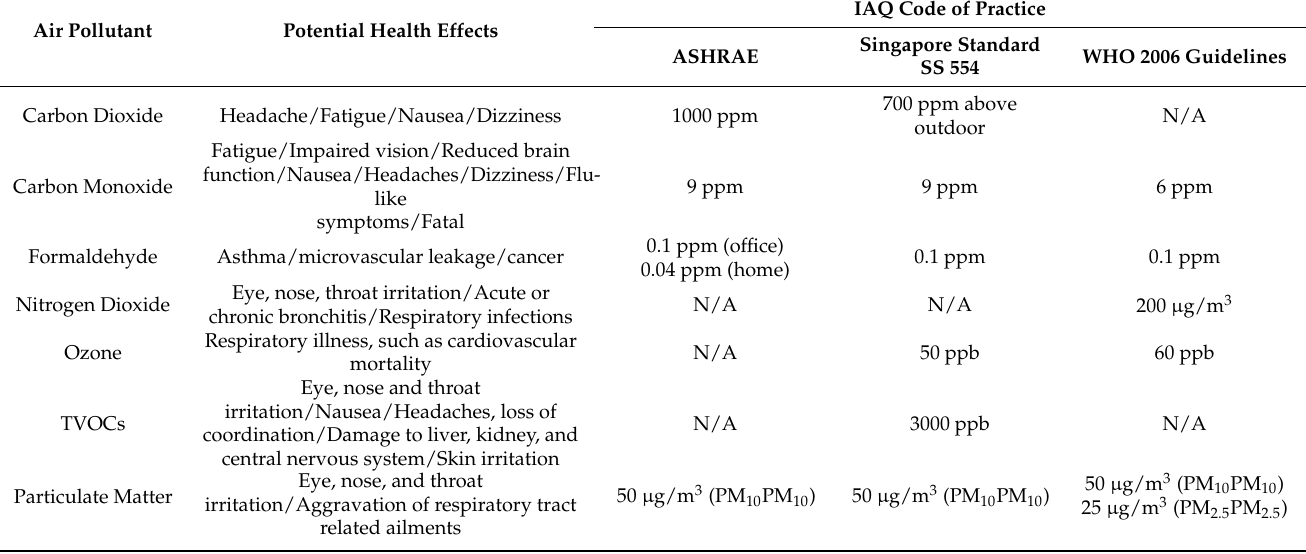
Table 1. The potential health effects and recommended levels of indoor air